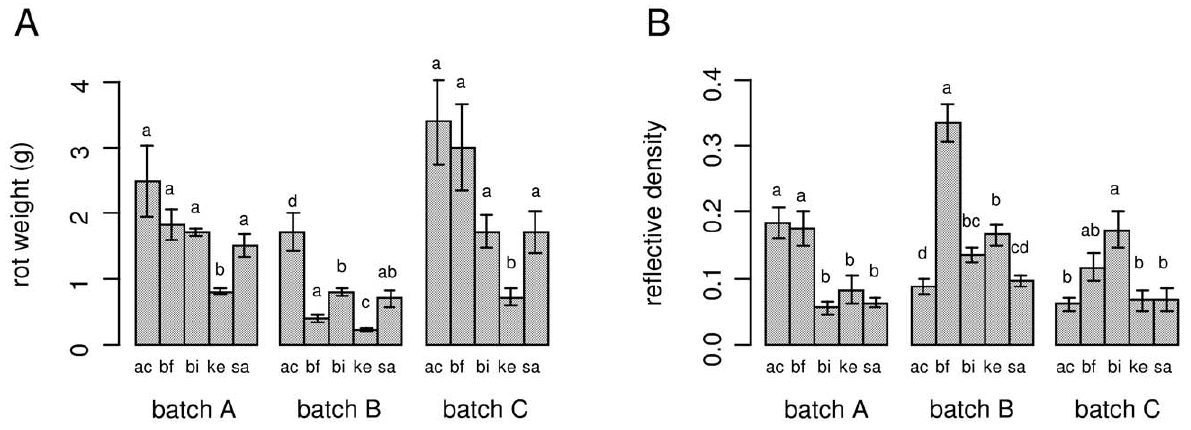
Figure 1. Disease severity caused by Pectobacteriumatrosepticum and Phytophthorainfestans in artificially inoculated potato tubers. For P. atrosepticum (A), rot weight was measured 5 days after inoculation of half tubers; for P. infestans (B), disease severity was expressed as the reflective density deduced with the image analysis software ImageJ from levels of grey recorded on tuber slices scanned 15 days after inoculation with the pathogen. Experiments were performed on tubers from five potato cultivars (ac=Ackersegen, bf=BF15, bi=Bintje, ke=Kerpondy, sa=Saturna), produced in 2008 and 2009. Tubers produced in 2008 were used after 8 months of storage (tuber batch A), tubers produced in 2009 were used after 2 months (tuber batch B) and after 10 months (tuber batch C) of storage. Data for batch C are means from two replicate experiments (vs. one for tuber batches A and B); for each cultivar and treatment, five tubers were used in each experiment. Bars correspond to means 6 standard error. Different letters above bars indicate significant differences between means of cultivars within a batch (Tukey’s test, p , 0.05).